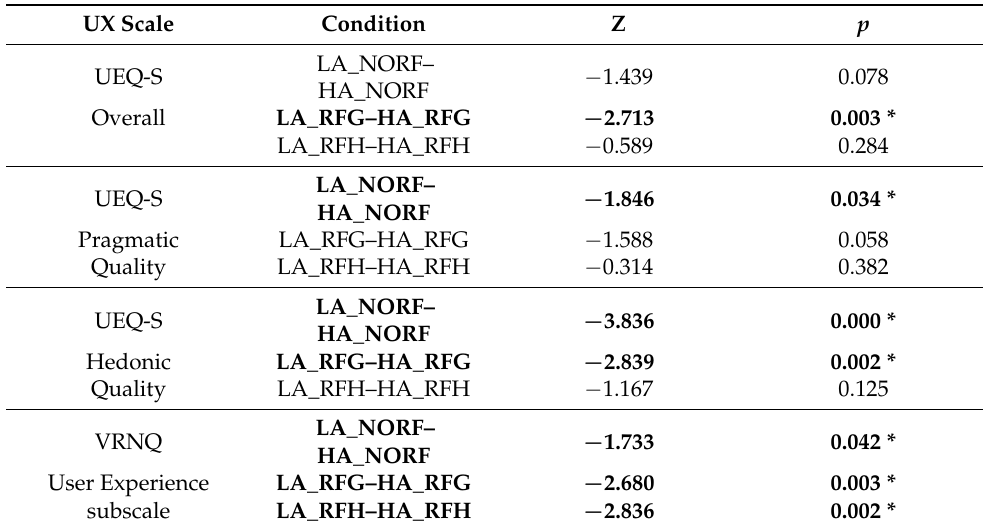
Table 7. Wilcoxon signed-rank test for user experience scores assessed by the UEQ-S and VRNQ (User Experience Section) Questionnaire between the modes of the game (LA vs.